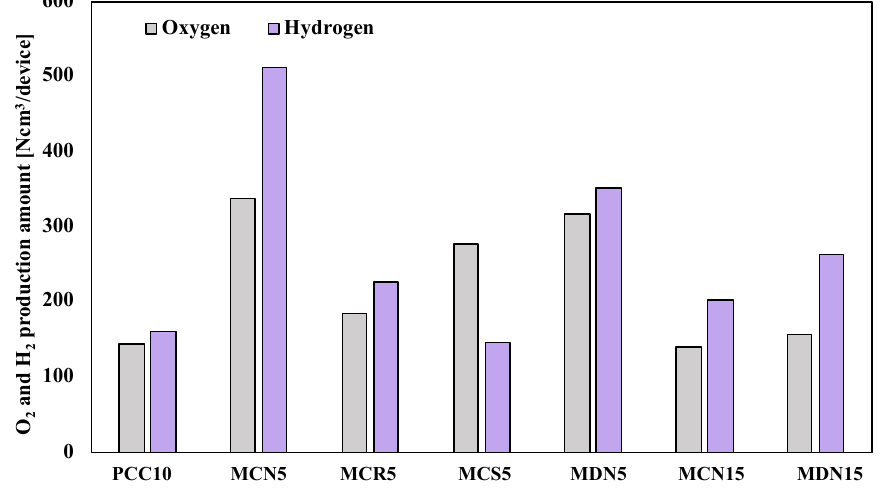
Figure 8. Total production amount of O 2 and H 2 through 5 cyclic tests (Ncm 3 /device).